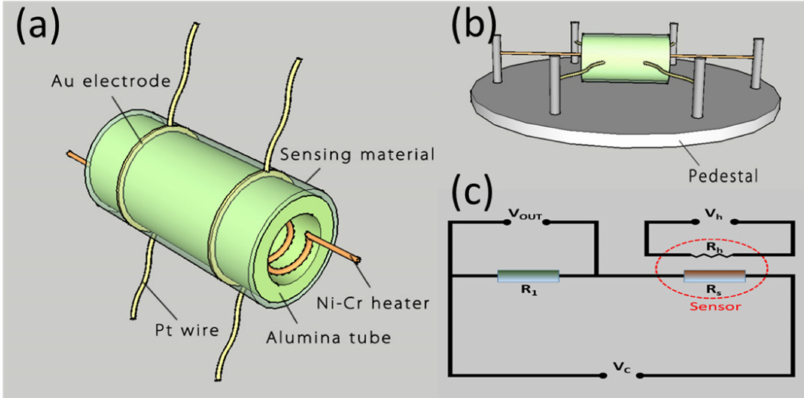
Figure 1. ( a , b ) Schematic illustration of the fabricated sensor. ( c ) Electric circuit of sensor